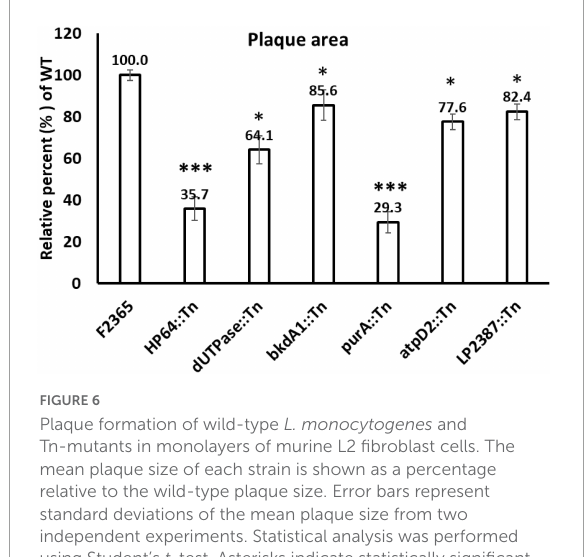
FIGURE6 Plaque formation of wild-type L. monocytogenes and Tn-mutants in monolayers of murine L2 fibroblast cells. The mean plaque size of each strain is shown as a percentage relative to the wild-type plaque size. Error bars represent standard deviations of the mean plaque size from two independent experiments. Statistical analysis was performed using Student’s t -test. Asterisks indicate statistically significant differences ( ∗ P < 0.05, ∗∗∗ P <